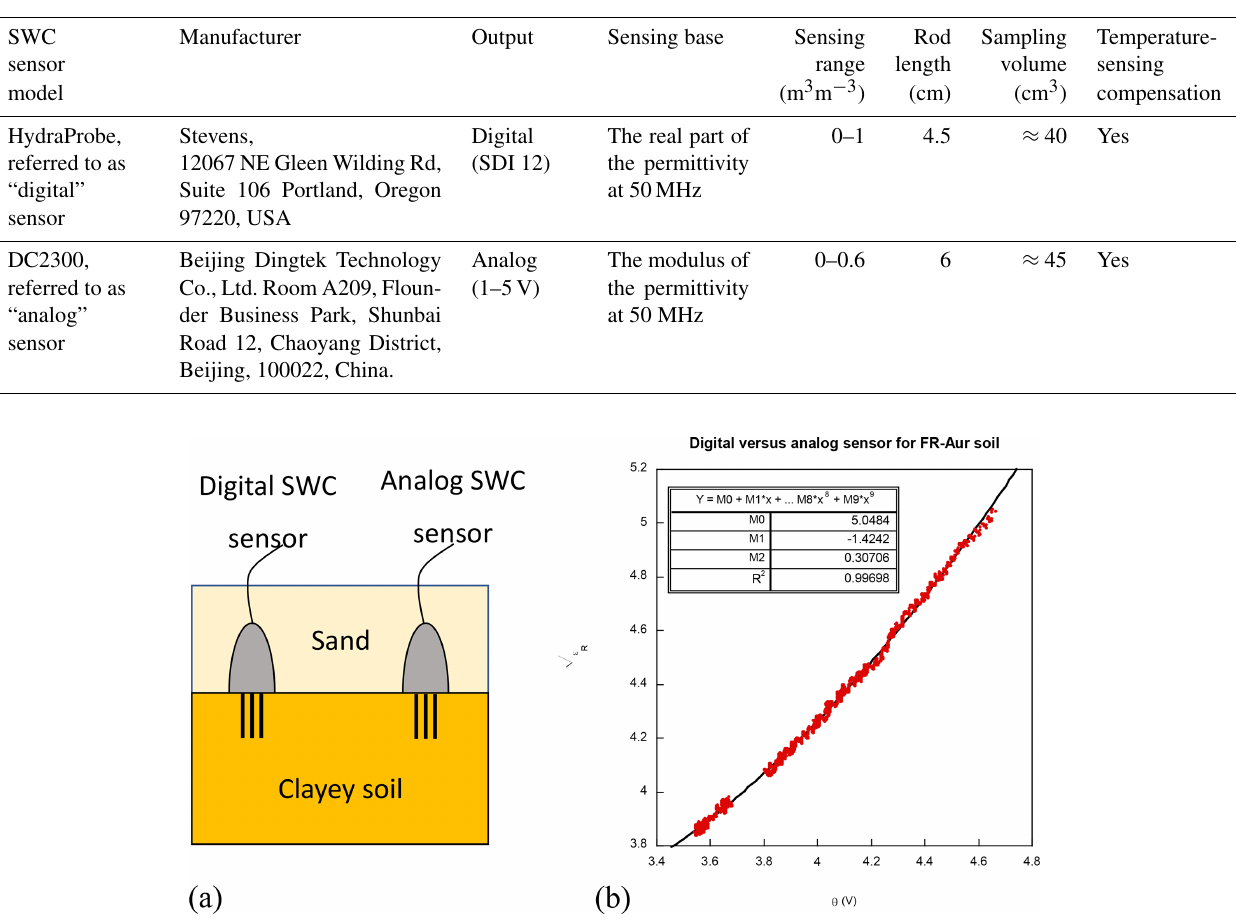
Figure 3. (a) Analog and digital FDR sensor cross-calibration configuration. (b) Graphic comparison of the square root of the real part of relative dielectric permittivity, indicated by the digital FDR sensor, versus the SWC θ value (in V) indicated by the analog FDR sensor. The table indicates the second-degree polynomial regression and the corresponding determination coefficient R 2 .